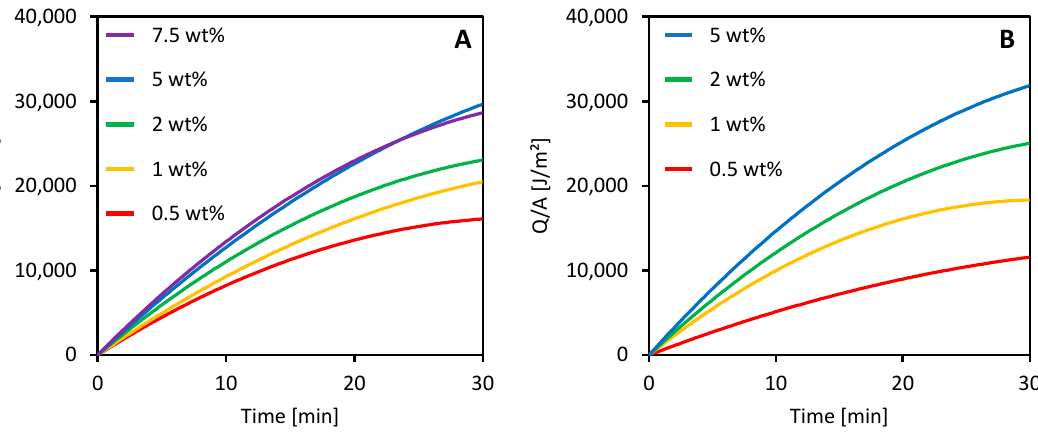
Figure 7. Heat generated by the irradiated membranes prepared with ( A ) 14.5 wt % and ( B ) 16 wt % PVDF and different CB loadings.